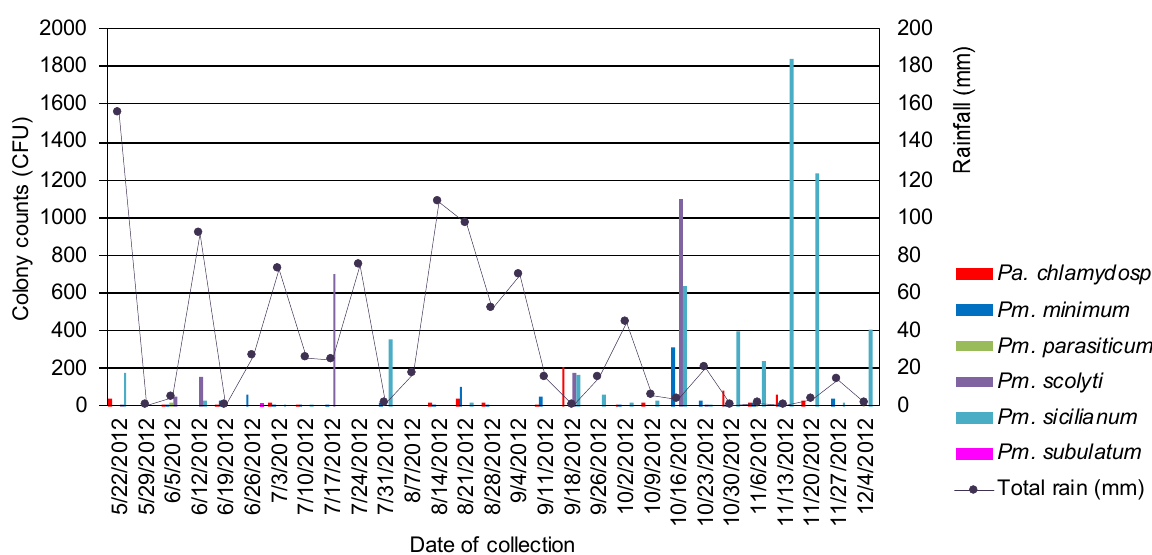
Figure 11. Phaeomoniella and Phaeoacremonium spp. cfu cultured from five vaseline coated microscope slides affixed to the cordons on each of five vines in a vineyard in Rawsonville, Western Cape province in 2012. The slides were replaced weekly. Each bar represents the total number of cfu cultured on three Petri dishes. Not clear on the graph, detection dates for Pm. parasiticum are 05/06, 06/11 and 04/12 and for Pm. subulatum is